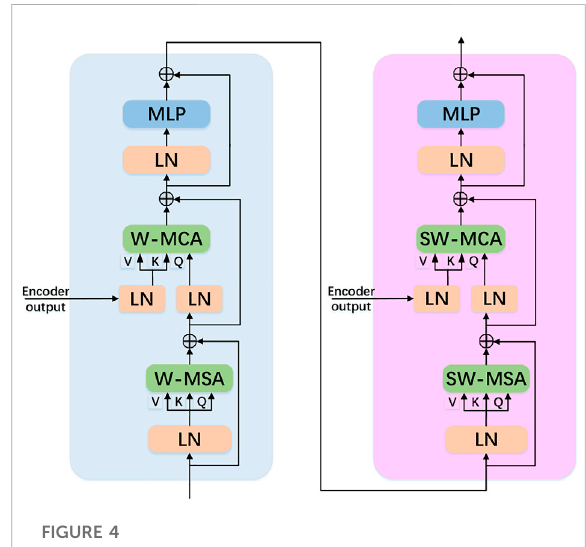
FIGURE 4 The structure of the swin transformer decoder